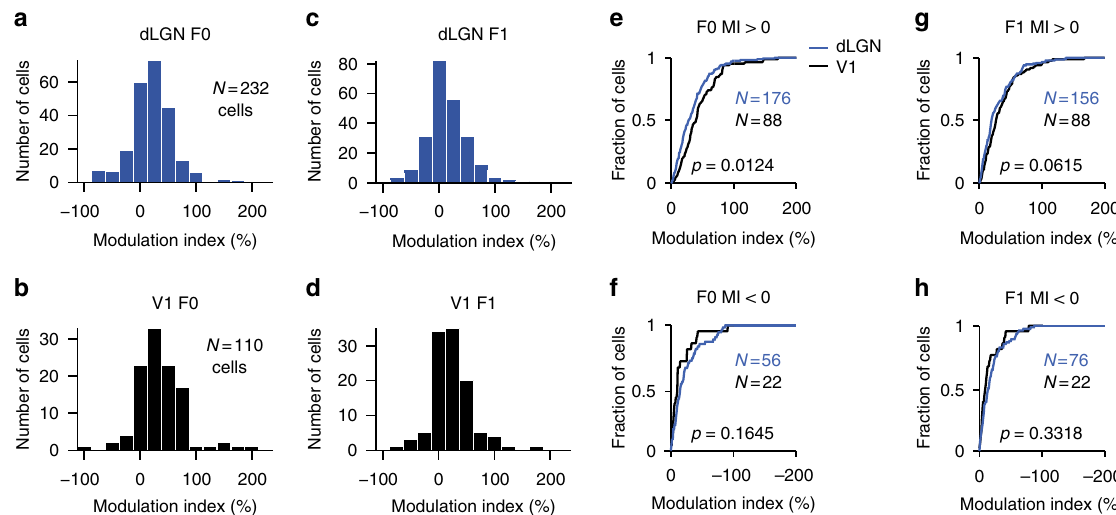
Fig. 3 Similar response amplitude modulations in dLGN and V1. a Distribution of fi ring rate (F0) modulations for dLGN neurons (TF experiments: n = 232 cells). b Same as a for V1 neurons (TF experiments: n = 110 cells). c Distribution of response amplitude (F1) modulations for dLGN neurons. d Same as c for V1 neurons. e Cumulative distributions of fi ring rate (F0) modulations for cells with positive modulation index (MI > 0). f Same as panel e for negatively modulated cells (MI < 0). g Response (F1) modulations for cells with positive modulation index (MI > 0). h Same as g for negatively modulated cells (MI <